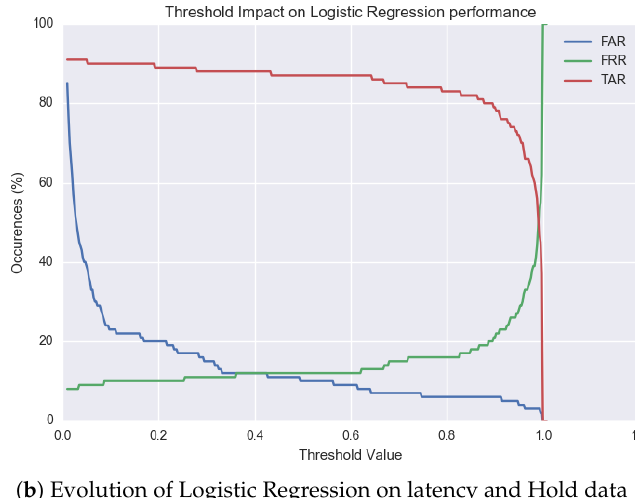
Figure 16. Ranking awarded to true user with Logistic Regression testing.